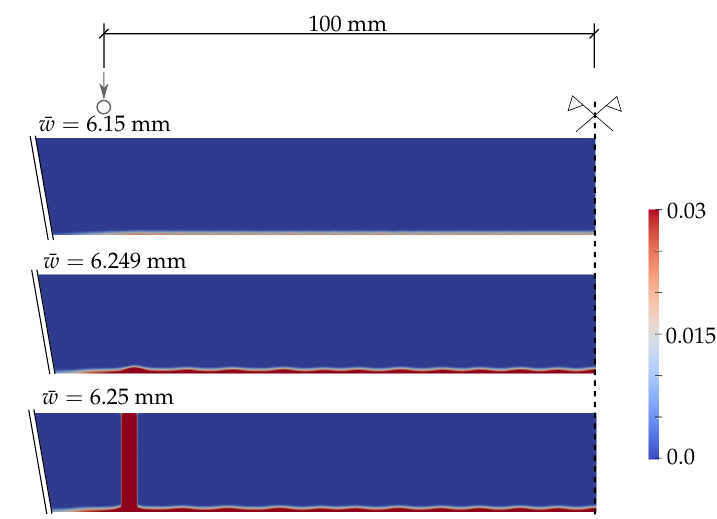
Figure 7. PS-Refined mesh, anisotropic staggered solver with the spectral-decomposition split: Evolution of the phase-field parameter using the PF-P formulation.